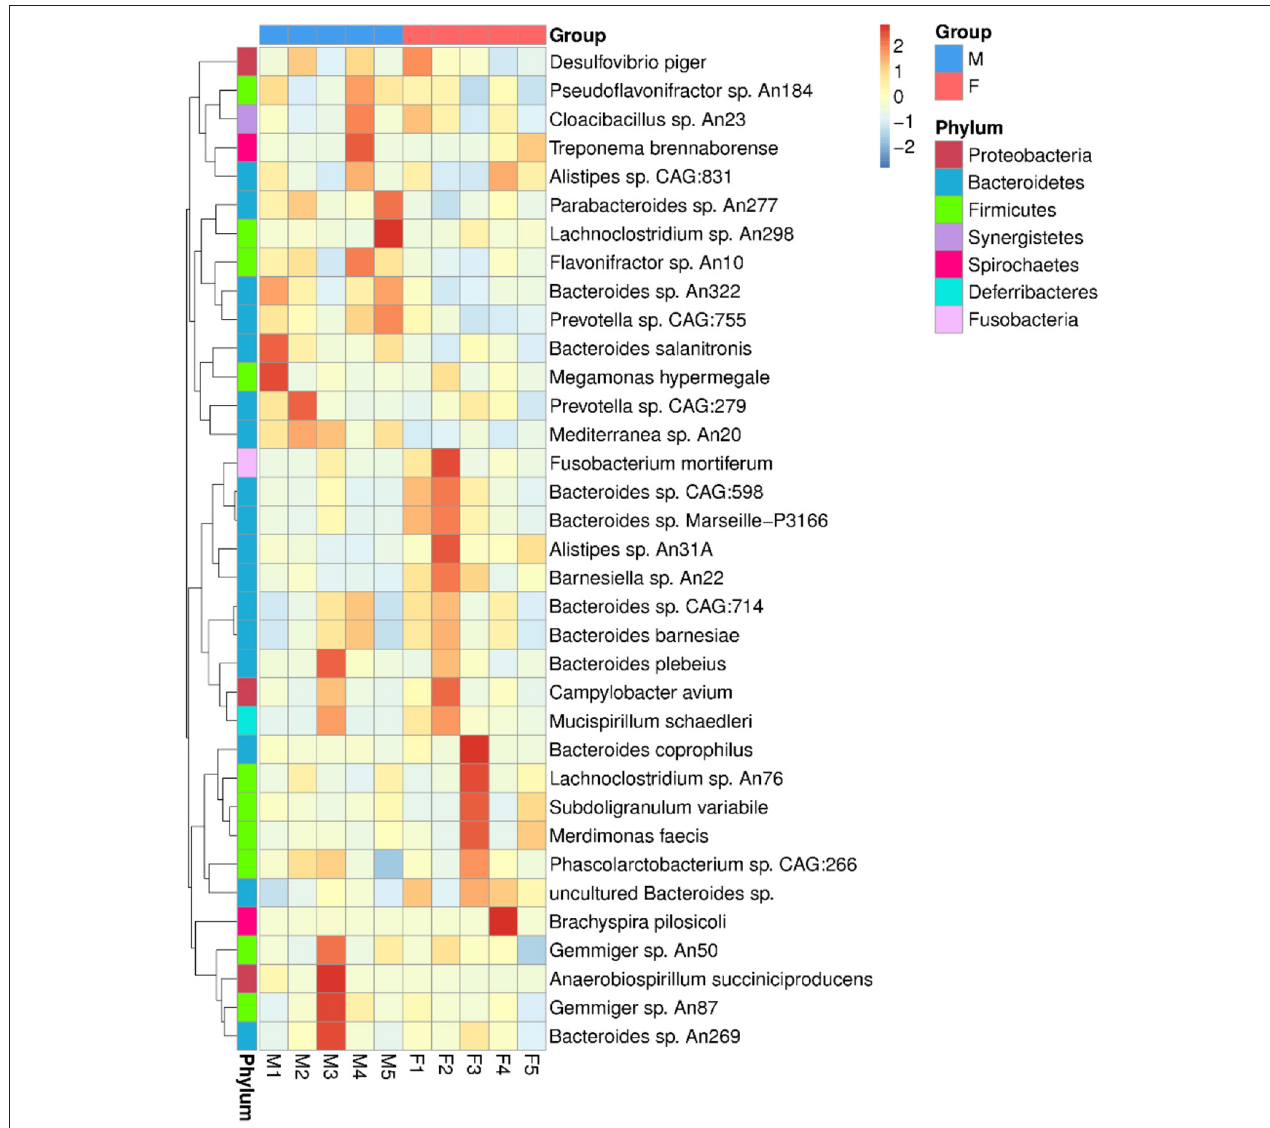
FIGURE 2 | The top abundant 35 bacterial species clustered in the cecal samples of female (F) and male (M) Japanese quail ( Coturnix japonica ). The value corresponding to each block was the Z value of each row of species, represented the standardized relative abundance. The Z value was the difference between the relative abundance of samples in the classification and the average relative abundance of all samples, and then divided by the standard deviation of all